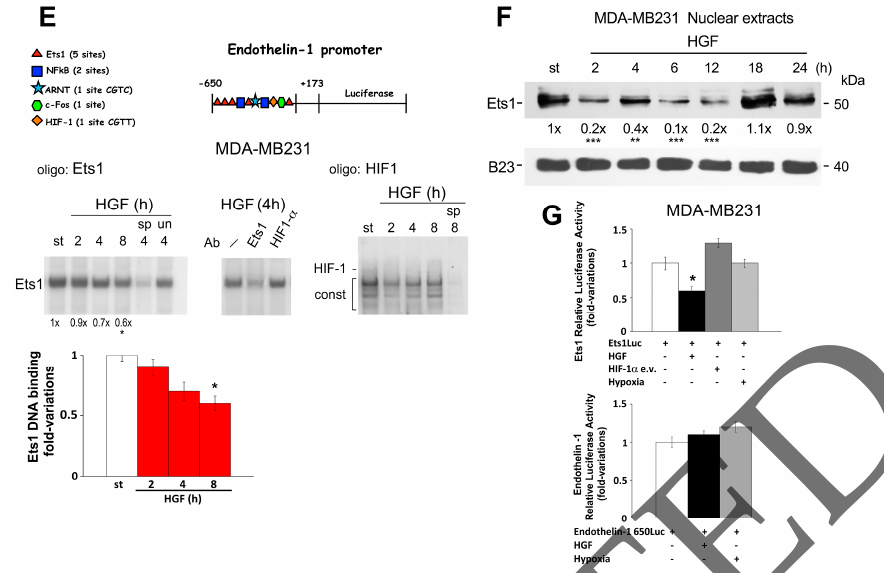
Figure 1. Endogenous miR-125b expression under osteoblast-conditioned medium in 1833 and MDA-MB231 cells, and effects of HGF or hypoxia on miR-125b expression and Ets-1 protein levels and activity in MDA-MB231 cells. ( A ) The conditioned medium from cultured MG-63 osteoblast-like cell line was added to starved 1833 and MDA-MB231 cells (+), and the expression of endogenous miR-125b was evaluated. The relative values were calculated using U6b as housekeeping gene. The experiments have been performed in triplicate, and the means ± S.E. are shown. * p < 0.05, ** p < 0.005 versus the respective white bar value (untreated cells). ( B ) The expression of endogenous miR-125b was evaluated in MDA-MB231 cells treated with HGF or hypoxia, and the relative values were calculated using U6b as housekeeping gene. The experiments have been performed in triplicate, and the means ± S.E. are shown. * p < 0.05 versus starvation value; ** p < 0.005, *** p < 0.001 versus control value. ( C ) Nuclear protein extracts from MDA-MB231 cells treated with HGF or hypoxia were analysed by Western blot, and immunoreactions were performed with anti-Ets-1 or anti-B23 antibody. The experiments were repeated three times. The densitometric values were normalized with B23, and the data were used to plot the histograms, which show the means ± S.E. of the fold variations versus the first bar, considered as 1. *** p < 0.001 versus starvation value. ( D ) Some MDA-MB231 cells were transfected with miR-125b mimic for 48 h, and were exposed or not to HGF for 24 h under starvation. The cells were seeded in the upper chambers, and Matrigel invasion was analysed in the absence of serum. The experiments were performed in triplicate. After cell count in selected fields, the values of migrated cells in 10 fields were calculated, and shown in the graphic as the means ± S.E. for the three replicate. ** p < 0.005, *** p < 0.001 versus starvation value; ° p < 0.05 versus the value in the presence of HGF. ( E ) The consensus sequences for the transcription factors in the Endothelin-1 promoter ( − 650/+173) are shown. Nuclear extracts, prepared from HGF-treated MDA-MB231 cells, were used for gel-shift assay (EMSA) with the oligonucleotide containing the Ets1 or the HIF-1 consensus sequence. Specific (sp) and unspecific (un) competitions were performed. Super-gel shift was carried out using anti-Ets1 or anti-HIF-1 α antibody (Ab), and the nuclear protein extracts from 4-h HGF exposed cells. The experiments were repeated three times. The numbers at the bottom indicate the fold variations versus starvation value, and in the histogram the data are shown as the means ± S.E. * p < 0.05 versus starvation value; ( F ) Nuclear protein extracts from MDA-MB231 cells treated with HGF were analysed by Western blot, and immunoreactions were performed with the antibodies shown. B23 was used for normalization. The experiments were repeated three times, and the densitometric evaluation was performed. The numbers at the bottom indicate the fold variations versus starvation value, considered as 1. ** p < 0.005, *** p < 0.001 versus starvation value; ( G ) The Ets-1 multimer and the Endothelin-1 gene reporter were transfected in MDA-MB231 cells, which were treated as shown. The histograms show the means ± S.E. of experiments performed in triplicate and repeated three times. * p < 0.05 versus basal Ets-1 luciferase activity.